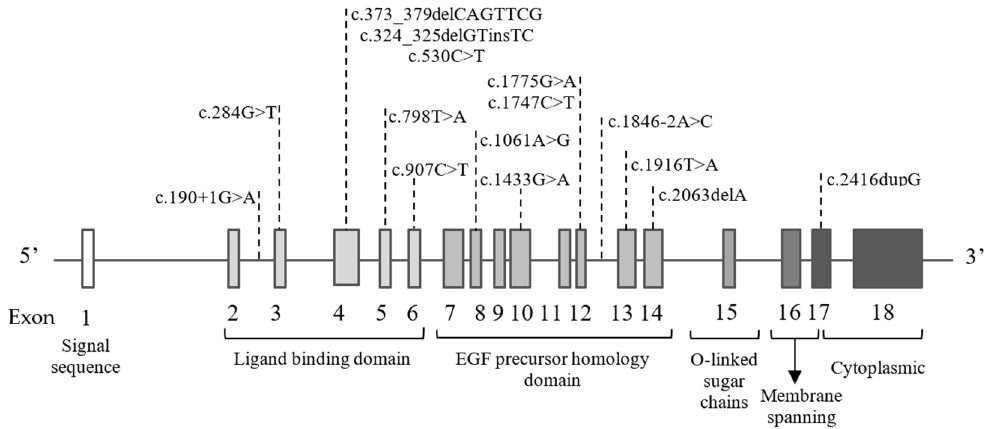
Figure 1. Schematic presentation of eighteen exons and six corresponding functional domains in the LDLR gene with the positions of the variants indicated.